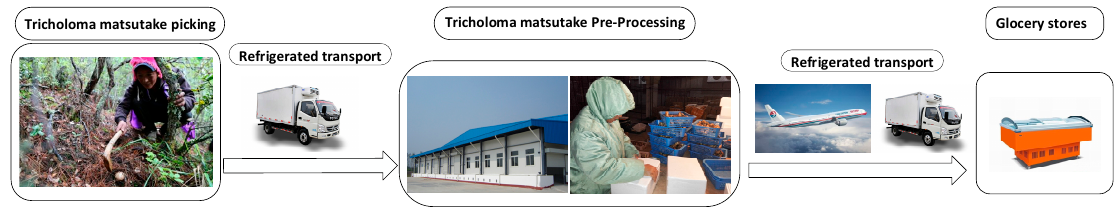
Figure 1. The supply chain of T. matsutake.